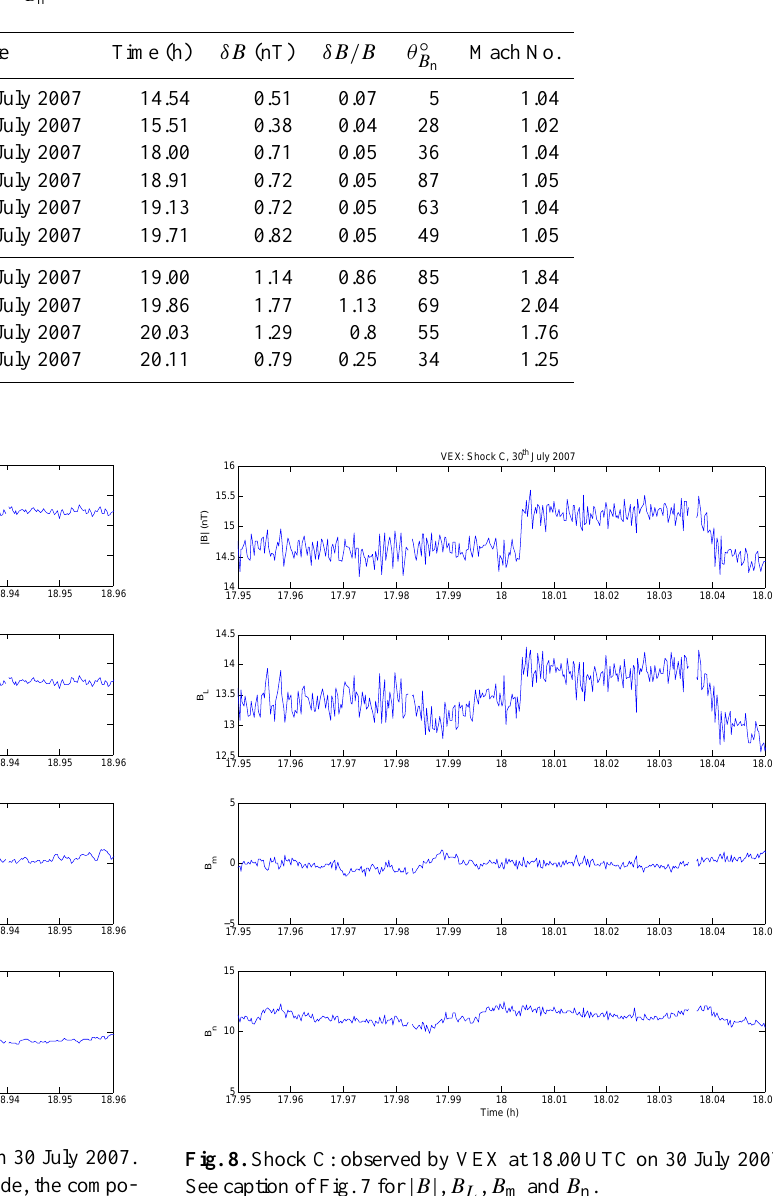
Table 1. Summary of shock properties observed at VEX and ACE during the leading CME crossing. Shocks A, B, C, D, E and F were observed by VEX on 30 July 2007 whereas shocks G, H, I, J were observed by ACE on 31 July 2007. The columns of the table left to right represent shock crossing date, shock crossing time, magnetic field jump ( 1B ), the ratio of magnetic field jump over magnetic field ( 1B/B ), the angle between the magnetic field and the normal ( θ B ) and Mach number. n